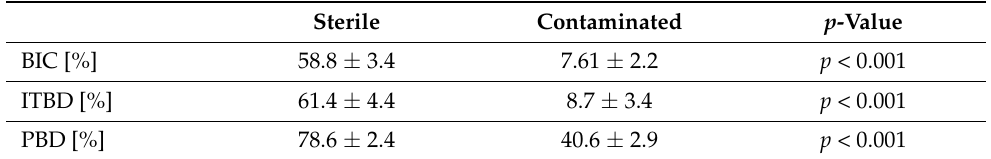
Table 1. The histomorphometric parameters are shown in Table 1. Compared to the sterile implants, the contaminated implants showed significantly reduced BIC values ( p < 0.001), irrespective of the placement. ITBD showed similar results: Sterile implants showed an interthread bone density of 61.3 ± 4.4% compared to the infected implants with an ITBD of 8.7 ± 3.4 % ( p < 0.001). The PBD values were higher around the sterile specimens, 80.8 ± 2.4 %, compared to contaminated ones, 43.9 ± 5.0% ( p < 0.001).